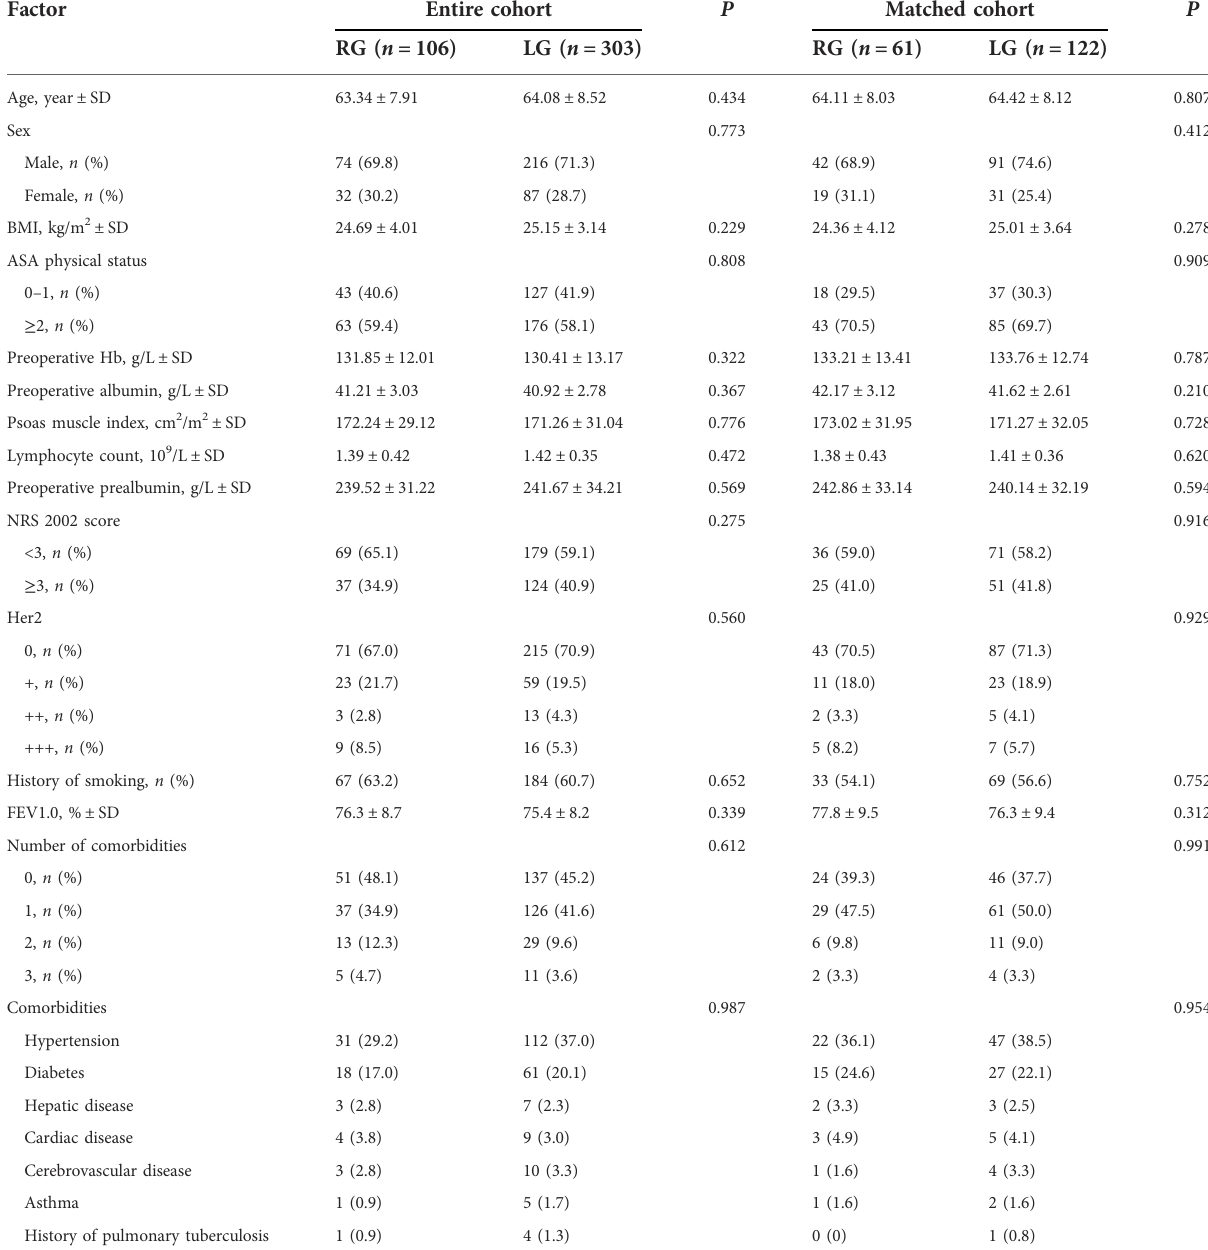
TABLE 1 Patient